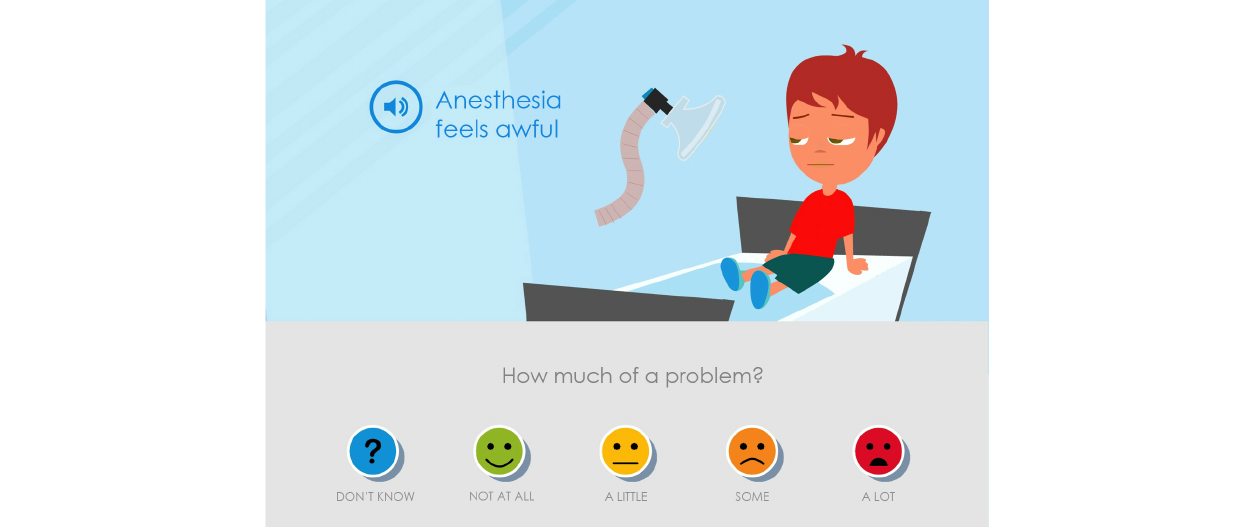
Figure 2. The parents and the pediatric nurses suggested that the statements should be more neutral than in this picture of the first version of Sisom